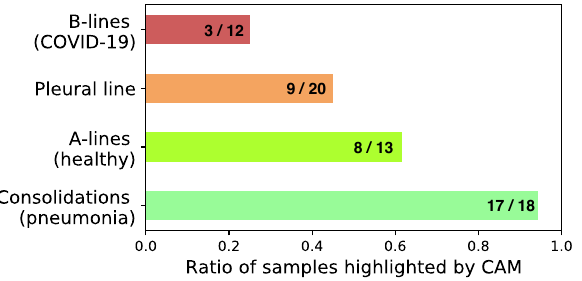
Figure 6. Pathological pattern highlighting. Patterns highlighted by CAMs compared to patterns visible in the video (colors correspond to success ratio in